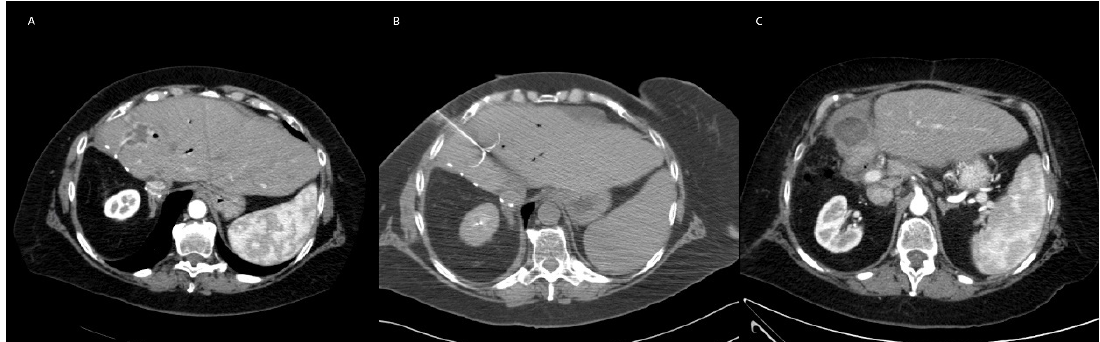
Figure 1. Representative Image of RFA. ( A ) 56-year-old female with hilar cholangiocarcinoma status post right hepatectomy and extra hepatic bile duct resection followed by multiple embolizations for residual disease. Referred for RFA ablation for treatment of enlarging segment 4A and 4B metastases in the setting of hepatic artery stenosis limiting repeat embolization. The preprocedural axial CT demonstrates a contrast enhancing hypoattenuating cholangiocarcinoma in segment 4 adjacent to the hepatectomy margin. ( B ) Intraoperative CT demonstrating percutaneous radiofrequency probe (Boston Scientific LeVeen) within the segment 4A liver mass. Delivered 190 watts for 15 minutes followed by 200 watts for 15 min without reaching impedance limit. ( C ) Axial CT one month fol- ment overlying the zone of ablation.